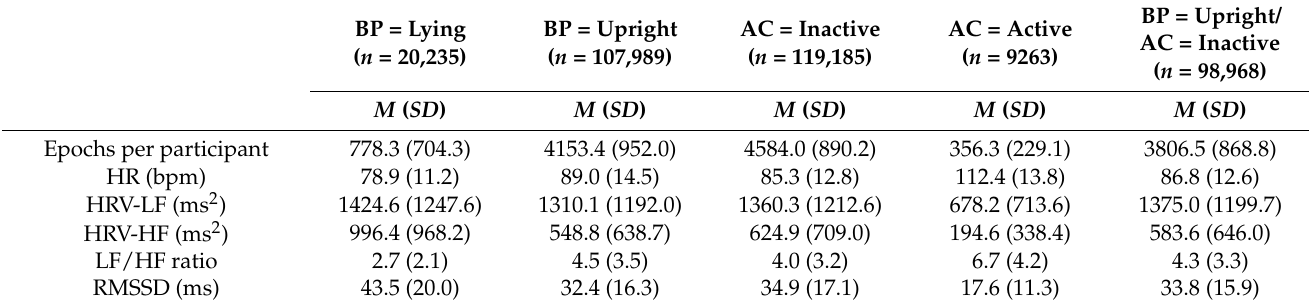
Table 3. Descriptive statistics for HR/HRV measures stratified for body position and activity class.